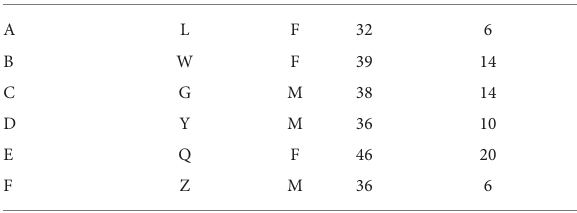
TABLE 1 Biographical information of the